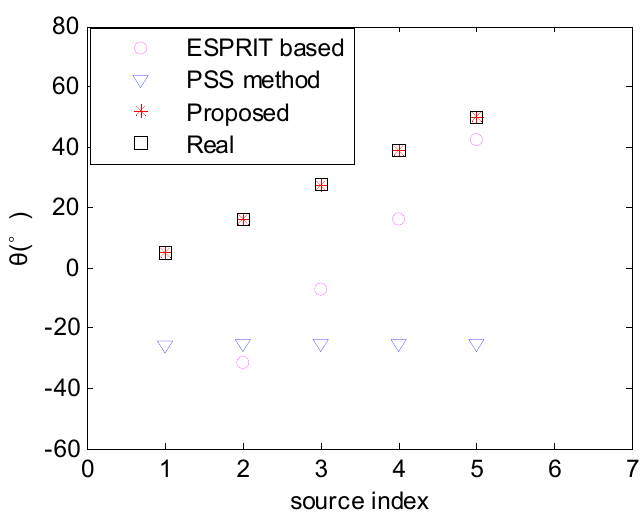
Figure 4. DOA estimation results with K = 5 sources (SNR = 10 dB).